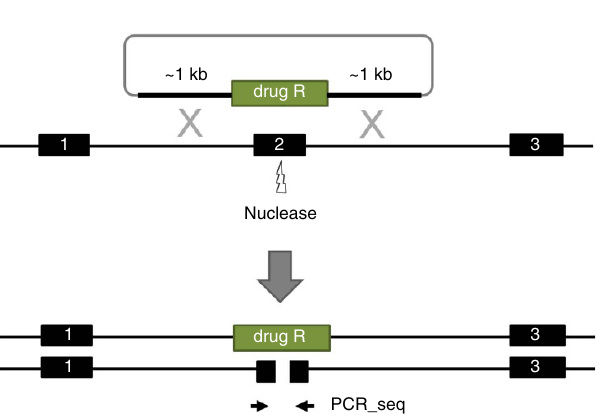
Figure 6 | Schematic diagram for the generation of biallelic knockout mutants. Strategy for the generation of biallelic knockouts is to replace a critical exon of one allele of the target gene with a drug selection cassette by homologous recombination and to screen clones for damage to the second allele induced by error-prone non-homologous end-joining (NHEJ). Since only one copy of the target exon will be present in correctly targeted clones, NHEJ-induced damage to the non-targeted allele can be simply assessed by Sanger sequencing of PCR products from the target